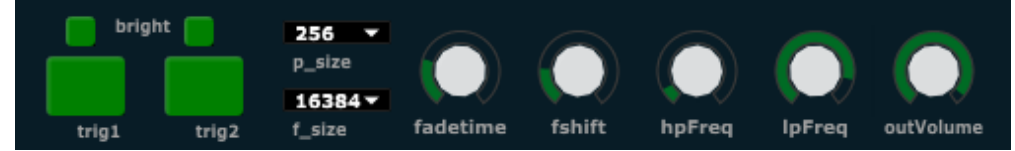
Figure 16. TV convolver